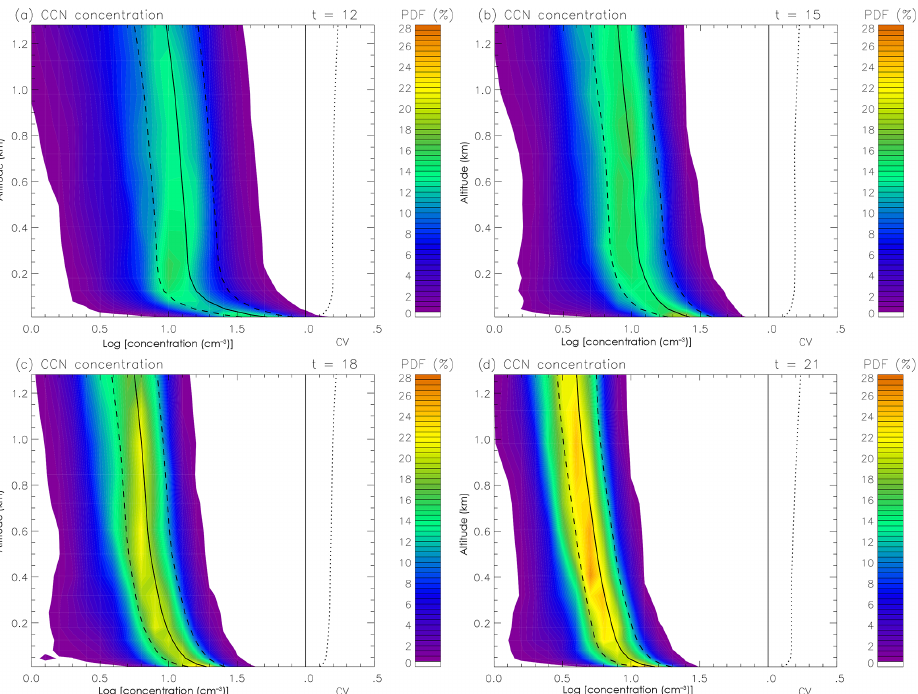
Figure 9. Altitude-dependent probability density function (a-PDF) in percent of the CCN concentration at different integration times. The a-PDFs are obtained calculating the PDF for each different level. A resolution of 0.1 is used for quantify the logarithm of the concentration. The lines represent the mean (solid lines) ± 1 standard deviation (dashed lines) of the CCN concentration. The dotted lines represent the coefficient of variation (CV) which is defined as the ratio of the standard deviation to the mean of the CCN